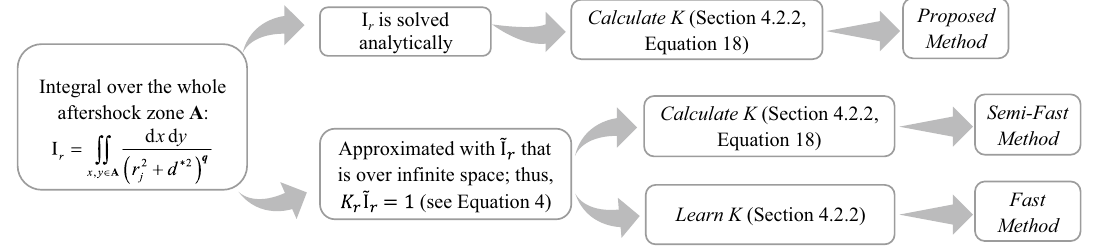
Figure 10. A schematic view of different approximations in the procedure to provide seismicity